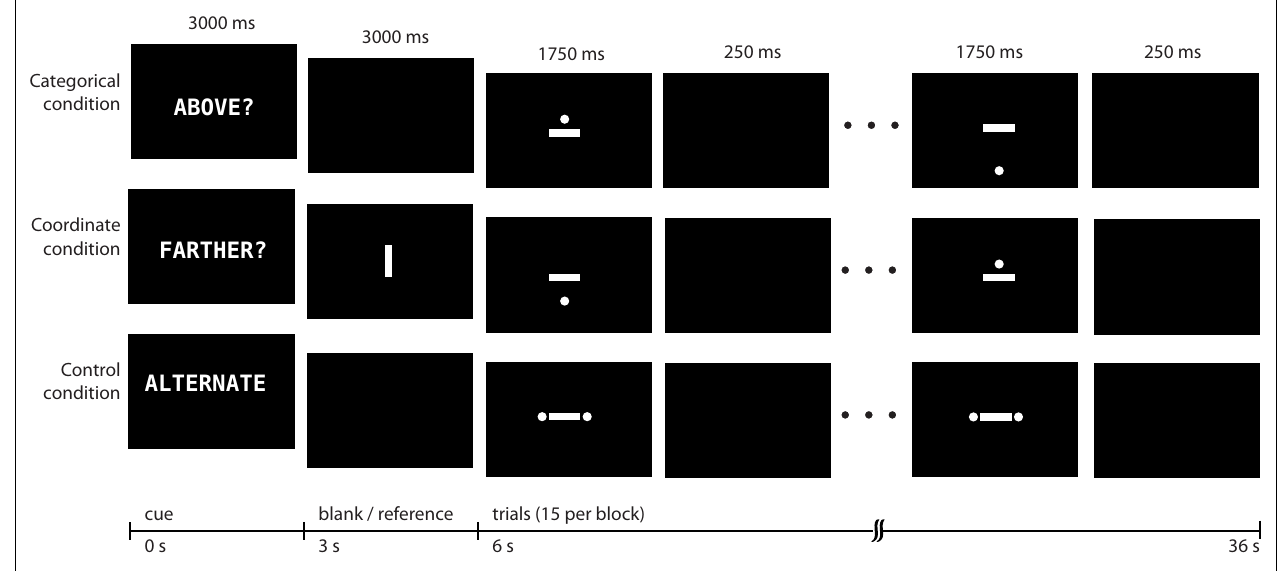
FIGURE 1 | Task conditions. Categorical, coordinate, and control conditions each occurred in 36-s blocks that were presented in pseudorandom